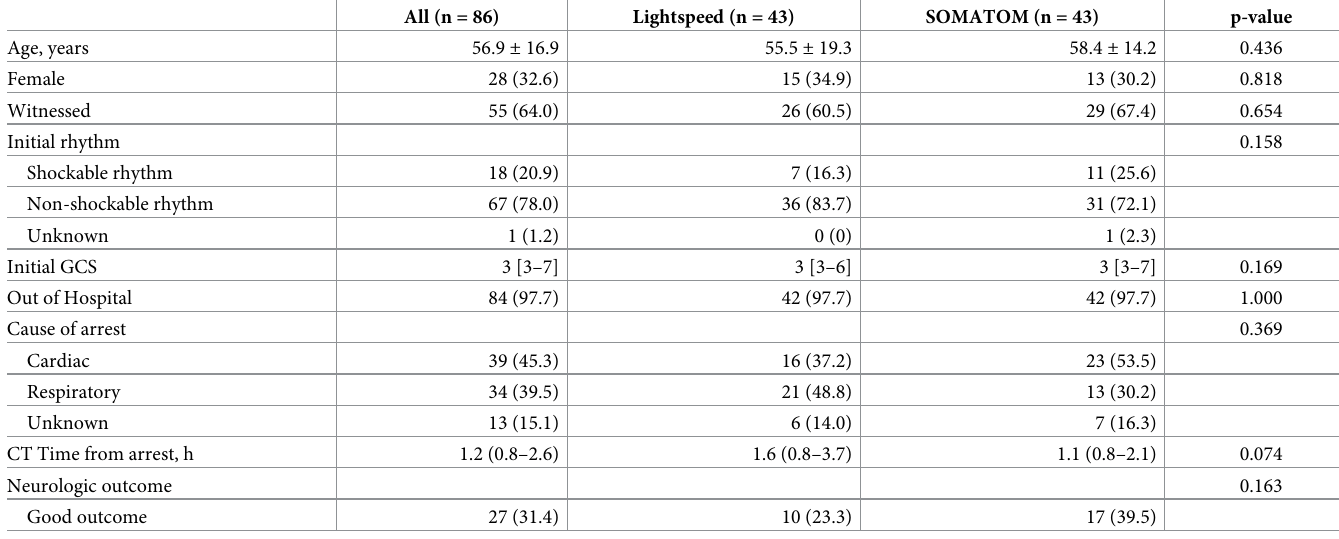
Table 1. Demographic characteristics.